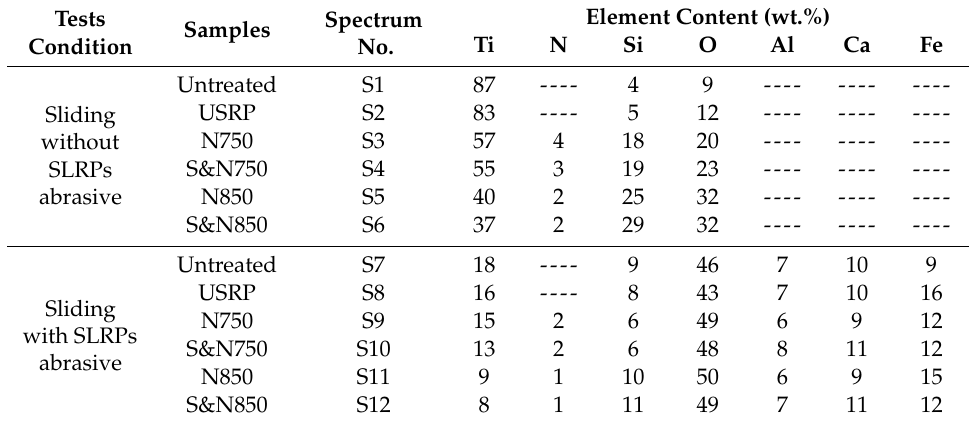
Table 4. EDS analysis results show the elementary composition of wear debris on a worn